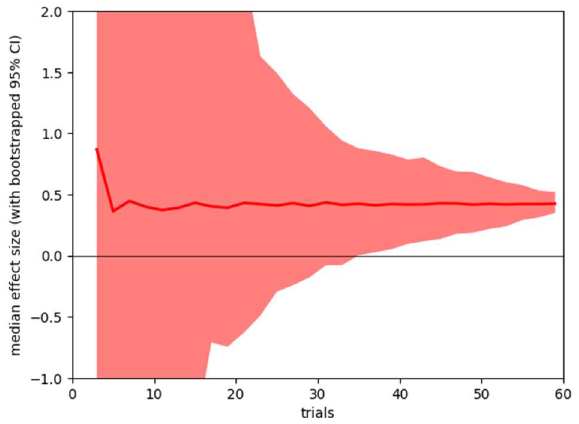
Figure 3: Sensitivity analysis, showing mean (line) and bootstrapped 95% confidence range (shaded area) for the effect size of pre-post caffeine microsaccade count difference for analysis based on 3 – 60